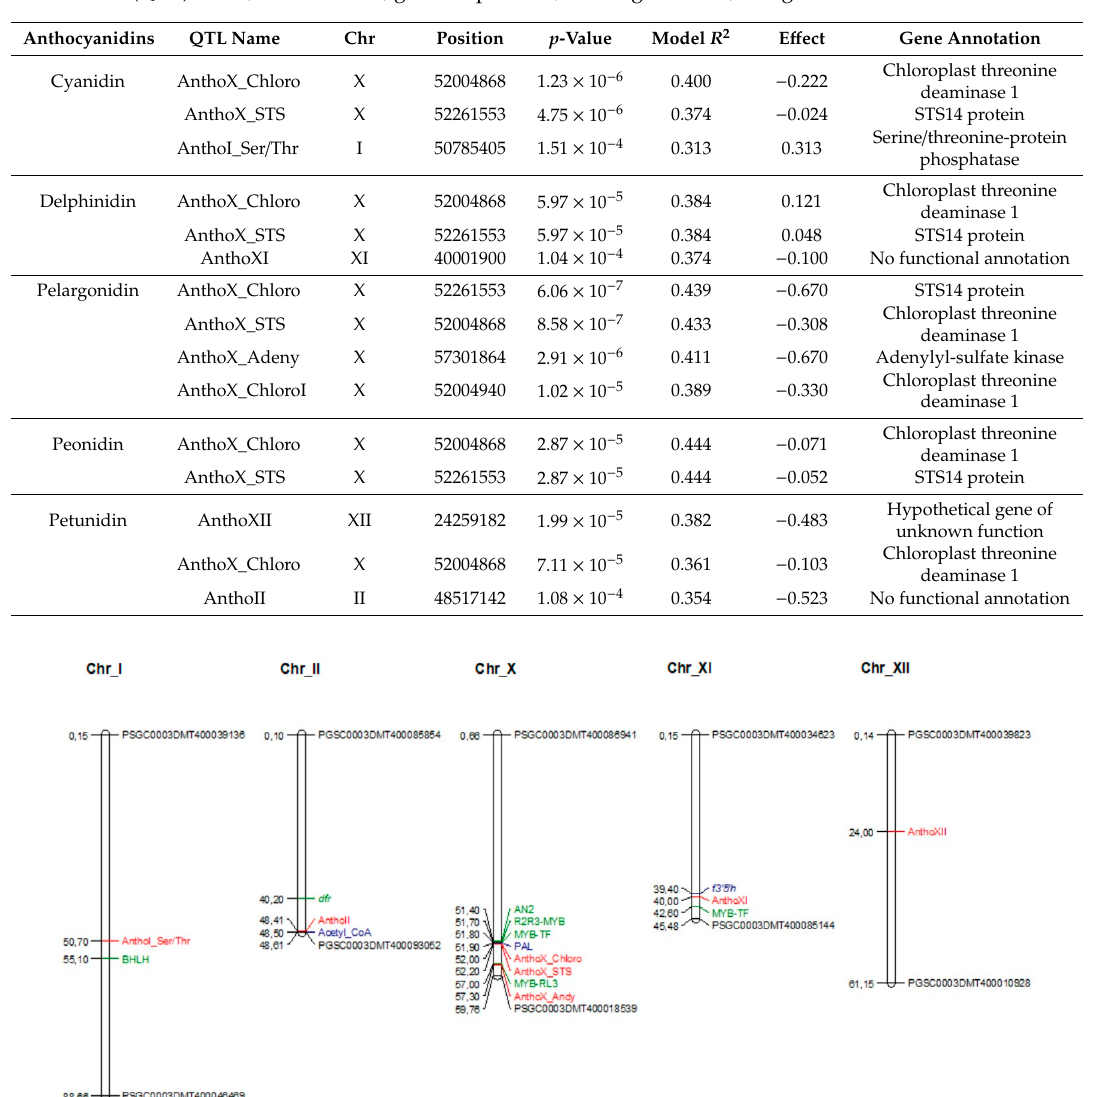
Table 1. Summary of genome associations for anthocyanidins content. Anthocyanidin, quantitative trait loci (QTL) name, chromosome, genome position, their significance, and gene annotation are shown. Anthocyanidins